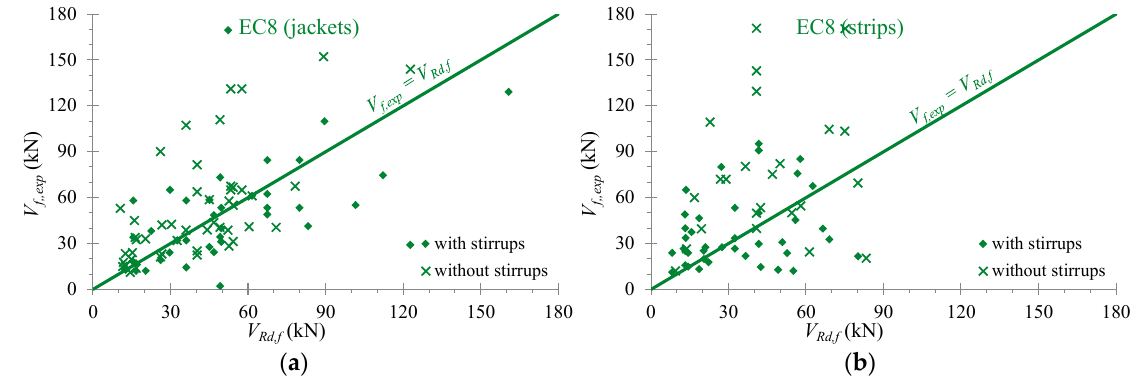
Figure 6. Results obtained based on the provisions of the Greek Code of Interventions (KAN.EPE.): ( a ) U-shaped retrofitted T-beams with EB-FRP jackets; ( b ) U-shaped retrofitted T-beams with EB-FRP strips.